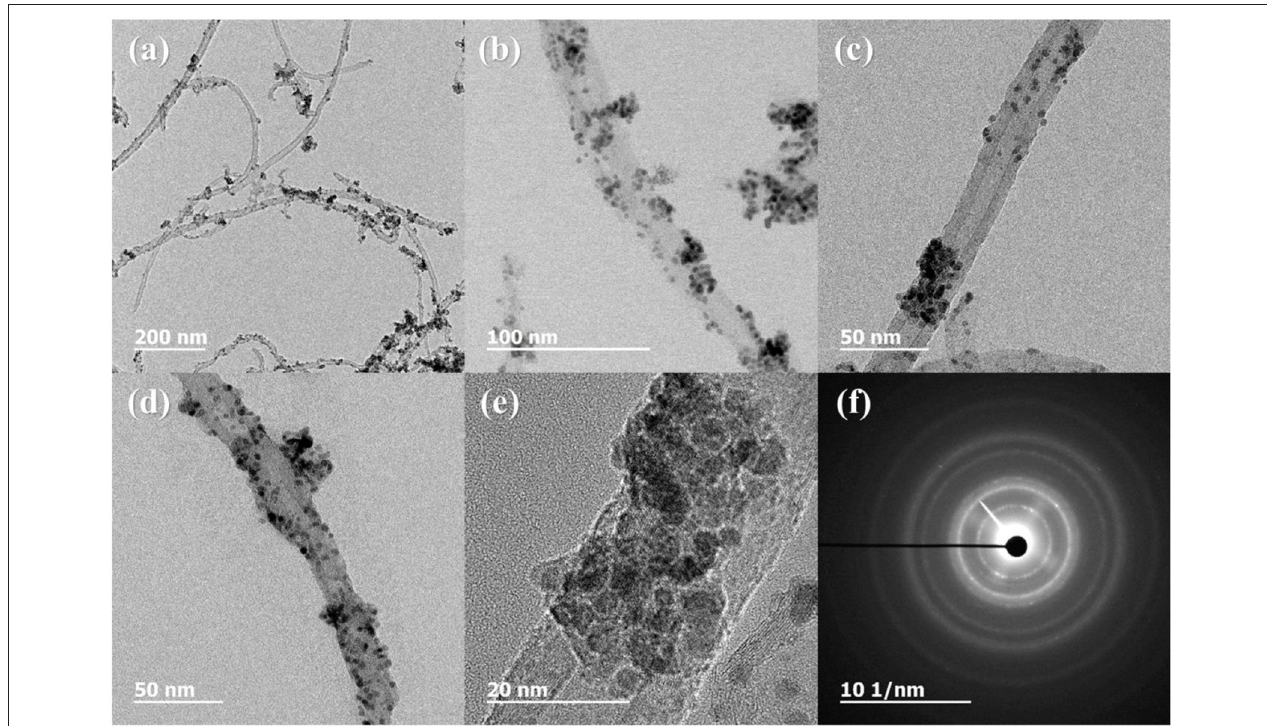
FIGURE 4 | TEM and HR-TEM images and selected area electron diffraction (SAED) pattern of Ni-Pd/MWCNT. (A) 200 nm scale, (B) 100 nm scale, (C,D) 50 nm scale, (E) 20 nm scale, (F) diffraction pattern of